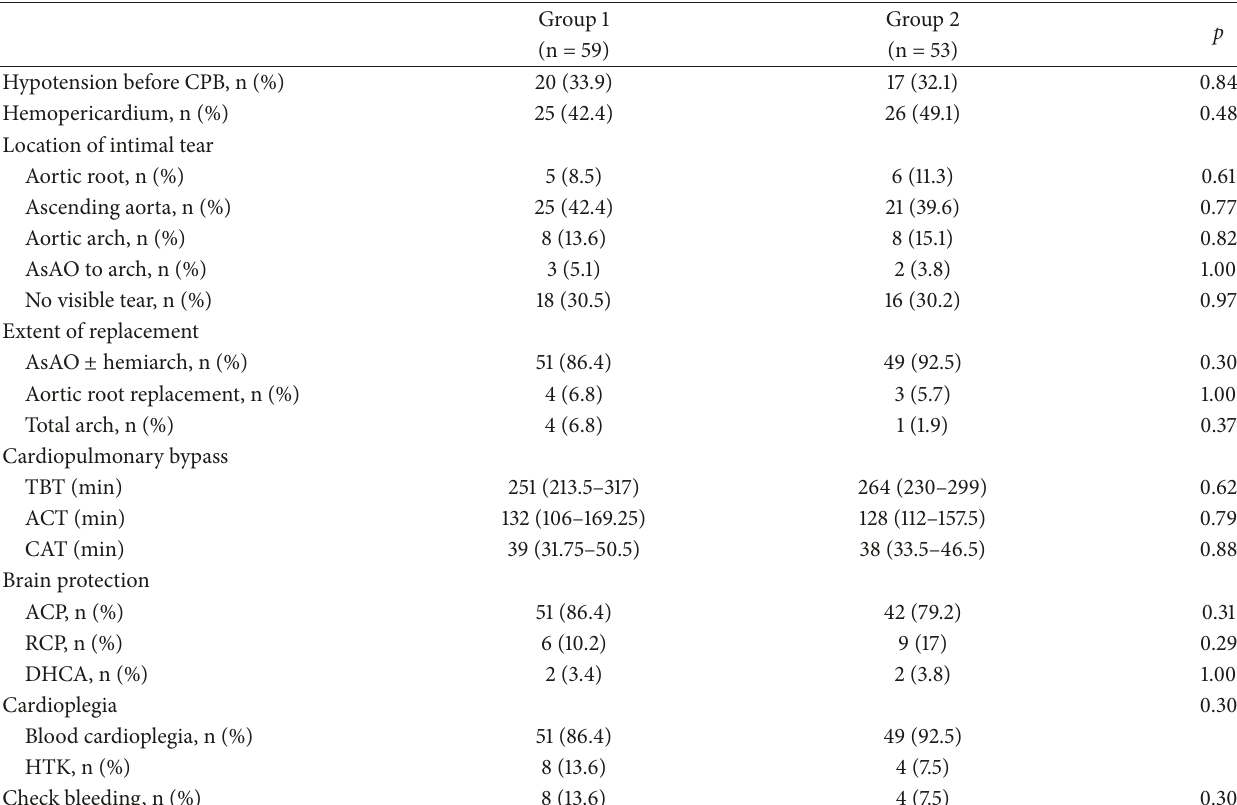
Table 3: Operative findings and methods.